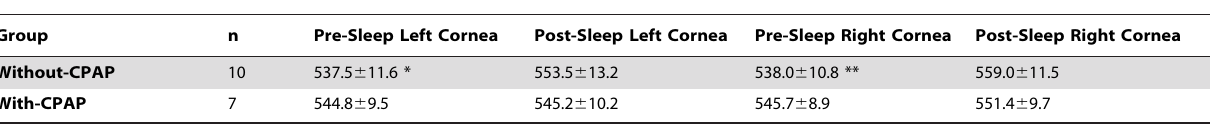
Group n Pre-Sleep Left